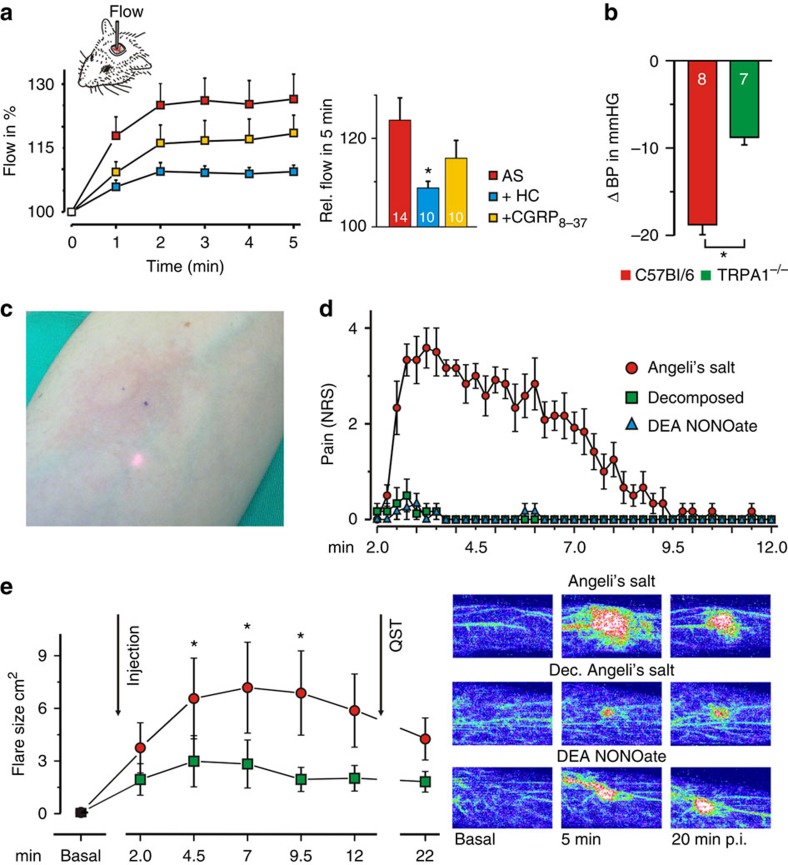
Vasodilation by HNO-induced CGRP release involves TRPA1
in vivo.(a) AS-evoked increase in meningeal blood flow measured in anaesthetized rats was significantly reduced by topical application of HC030031 (50 μM) (mean±s.e.m., repeated measures ANOVA and HSD post hoc tests, *P<0.05, n given in the figure). (b) AS-induced drop in MAP under anaesthesia was smaller in TRPA1−/− than in C57Bl/6 mice (P<0.002; U-test; n=7). (c) Photograph of a subject’s volar forearm with noticeable axon-reflex erythema upon intradermal injection of AS (0.7 μmol). (d) Magnitude and time-course of AS (0.7 μmol)-evoked pain in human volunteers (n=6, 3 male and 3 female) on a numerical rating scale (NRS 0–10). Decomposed Angeli's salt and DEA NONOate (0.23 μmol) were used as controls. (e) Areas of increased superficial blood flow following injections of AS and decomposed AS as a control. QST indicates time point of quantitative sensory testing. Pseudocolor representations of laser Doppler scanned images of superficial blood flow evoked by injection of AS, DEA NONOate and decomposed AS (repeated measures analysis of variance, least significant difference post hoc tests; *P≤0.05; n=6; all error bars represent s.e.m.).